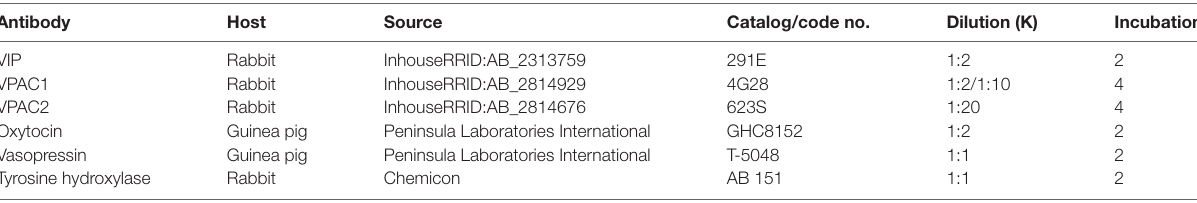
TABLE 1 | Primary antibodies.